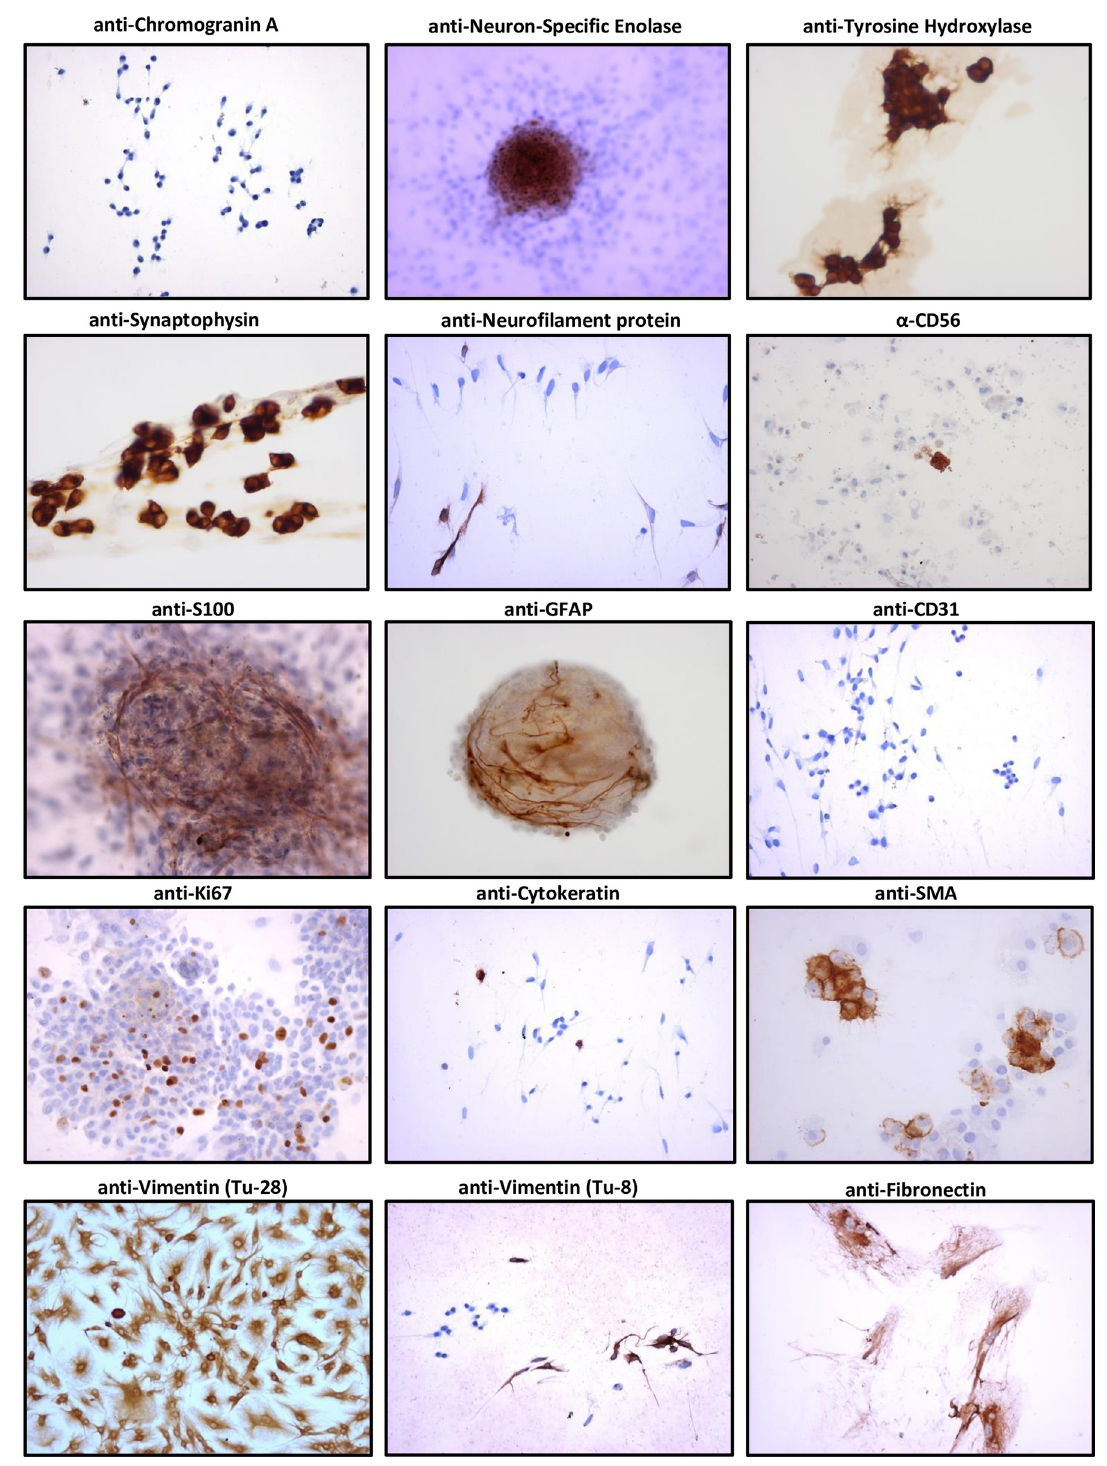
Fig 4. Summary of immunocytochemical staining of PPGL tumour cultures. Both chromogranin A (Tu8_Chromogranin A_10x obj.) and neuron-specific enolase (Tu-28_Neuron-specific enolase (NSE)_10x obj.) are generally negative, even in very early cultures. Tyrosine hydroxylase staining (Tu36_Tyrosine hydroxylase (TH)_40x obj.) is often positive, even in long-term cultures, but as many HNPGL cultures are negative for TH at the outset this marker is not generally applicable. In our hands the most broadly reliable marker in PPGL tumour cultures proved to be synaptophysin (Tu18_Syn_40x obj.), as this marker can be found in both early and late cultures.